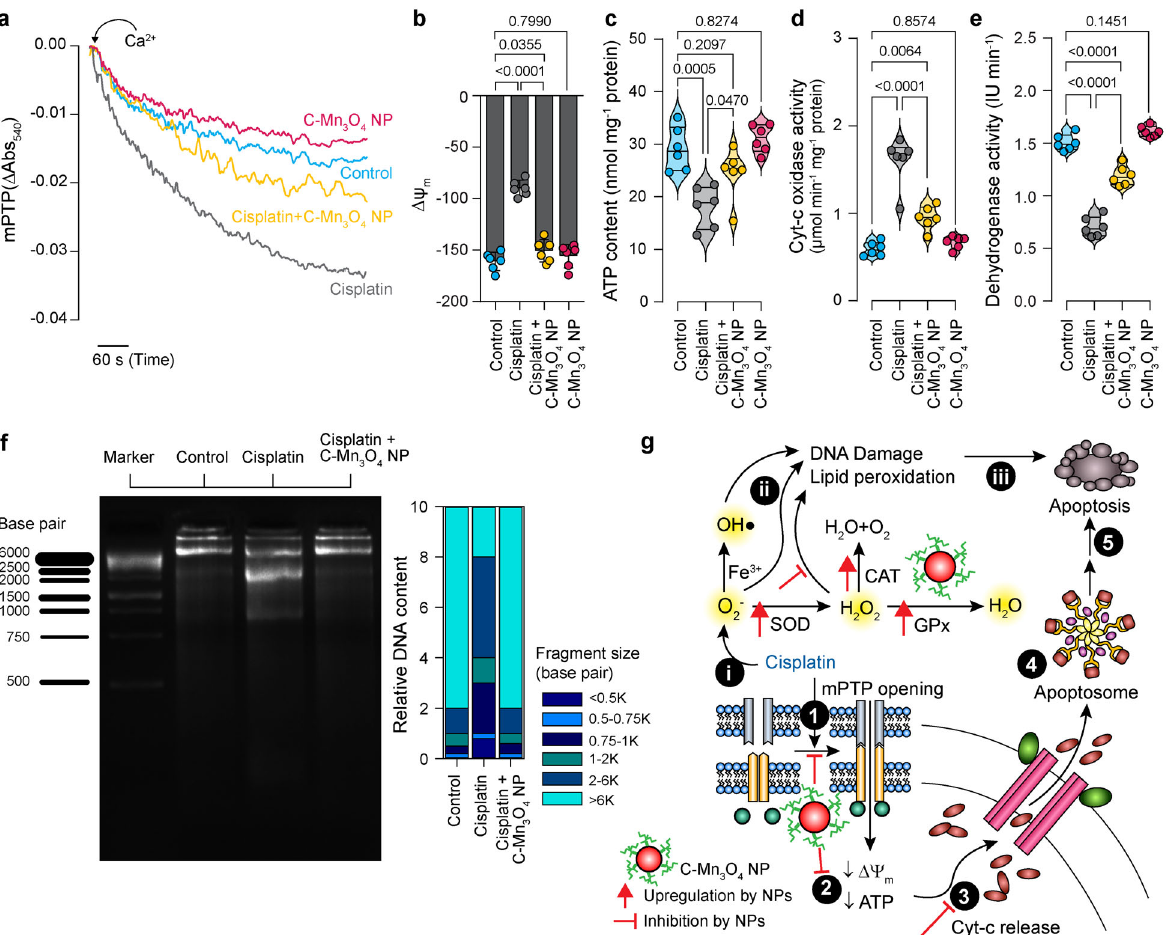
Fig. 6 Ef fi cacy of C-Mn 3 O 4 NPs in the protection of mitochondria, the master redox regulator in mice. a Ca 2 + induced mPTP opening measured by the decrease in 540 nm absorbance. b Mitochondrial membrane potential ( Δψ m ) estimated using JC-1 fl uorescence. c ATP content. d Cytochrome c oxidase (complex IV in the electron transport chain, ETC) activity in isolated mitochondria. e Succinate dehydrogenase (SDH, complex II in ETC) activity in isolated mitochondria. f DNA fragmentation level as a result of oxidative damage measured using agarose gel electrophoresis. In cisplatin-induced CKD animals DNA ladder formation, indicative of apoptotic DNA fragmentation, is clearly visible. The corresponding stacked bar plot shows the relative abundance of different-sized fragmented DNA in relation to the total DNA content of the lane. g Schematic overview of the comprehensive molecular mechanism of action of C-Mn 3 O 4 NPs as a redox medicine against cisplatin-induced CKD. The numbers in the black circles indicate the sequence of events. In bar plots data were expressed as Mean ± SD. Violins depict kernel density estimation of the underlying data distribution with the width of each violin scaled by the number of observations at that Y-value. Three lines (from the bottom to the top) in each violin plot show the location of the lower quartile (25th), the median, and the upper quartile (75th), respectively. The shaded area indicates the probability distribution of the variable. Individual data points are represented as colored circles ( N = 10). One-way analysis of variance (ANOVA) followed by Tukey ’ s post hoc multiple comparison test was performed for comparison among the groups. The numbers inside the plots indicate numerical p values. p < 0.05 is considered signi fi dependent plasma concentration pro fi le of C-Mn 3 O 4 NPs in order to fi gure out how the nanoparticles are absorbed into and eliminated from the bloodstream. Intraperitoneal (i.p.) adminis- the plasma Mn concentration vs. time pro fi le displayed in Fig. 7a.